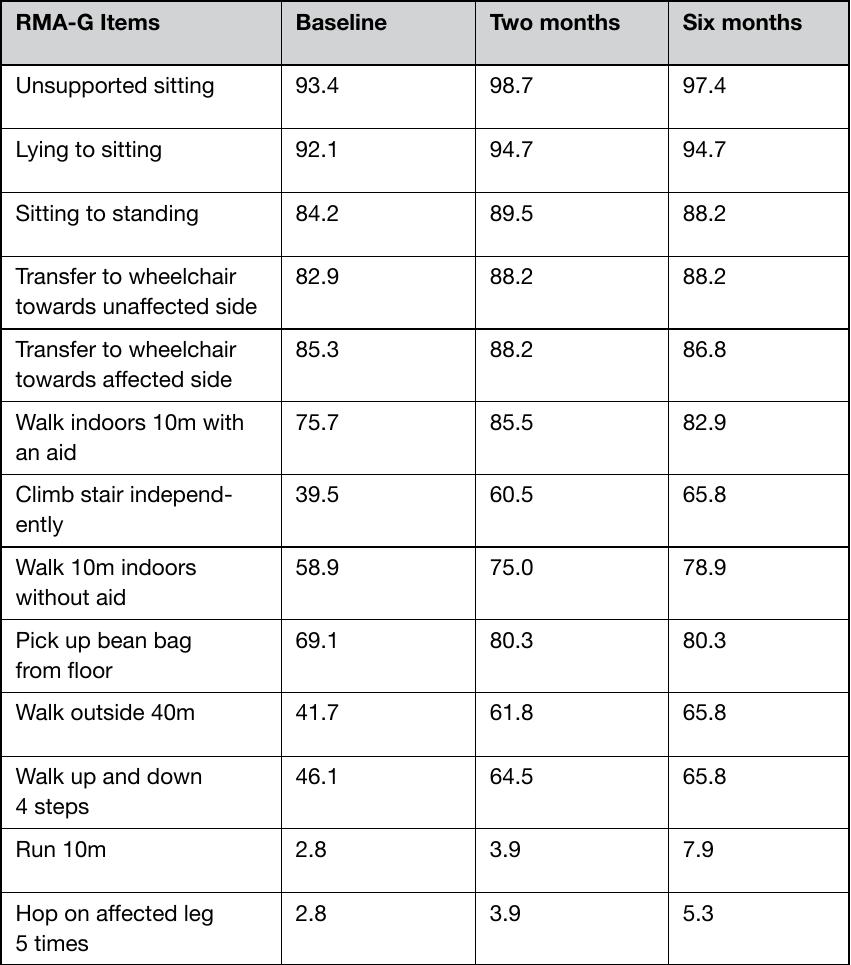
Table 1: Percentage of participants who were independent on the 13 sub-items of